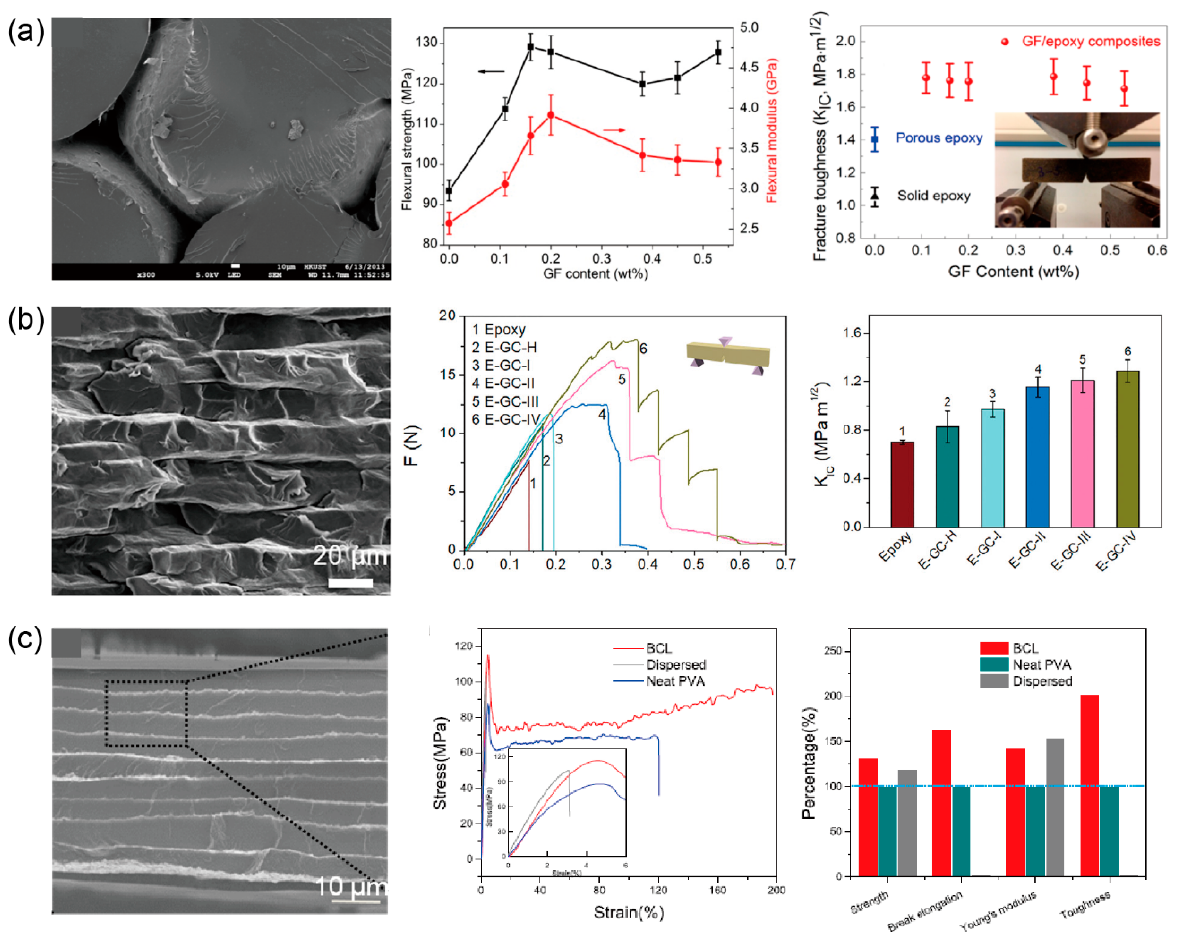
Figure 15. Graphene/polymer nanocomposites with polymer infiltrated into graphene scaffold and bi-continuous mi- crostructure. ( a ) RGO/epoxy composites, in which the graphene scaffold was grown on a Ni foam template, showing enhanced flexural modulus, strength, and fracture toughness compared to pure epoxy. Reprinted with permission from [190]. ( b ) RGO/epoxy composites with well-aligned rGO-CMC (carboxymethyl cellulose sodium) scaffold by ice templating, showing enhanced fracture strength and toughness. Reprinted with permission from [45]. ( c ) Bi-continuous GO/PVA composites, showing overall enhancement of mechanical properties including Young’s modulus, strength, break elongation, and toughness compared to pure PVA. Reprinted with permission from